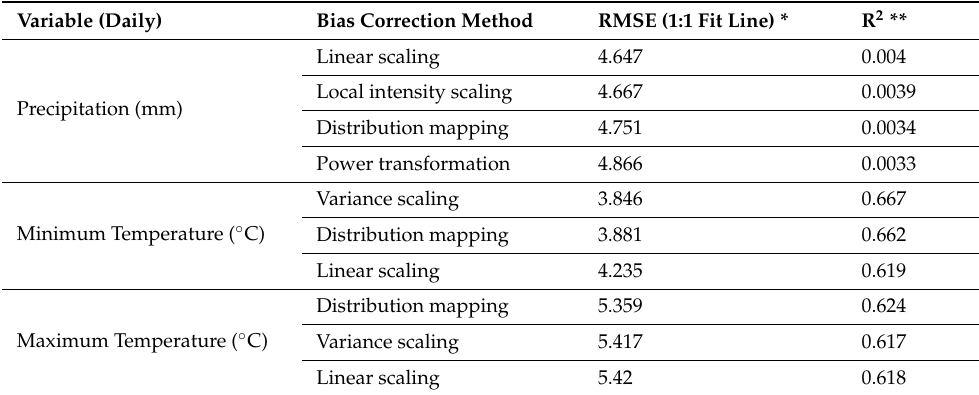
Table 5. Performance results of different bias correction methods for AL0019 station for the control period